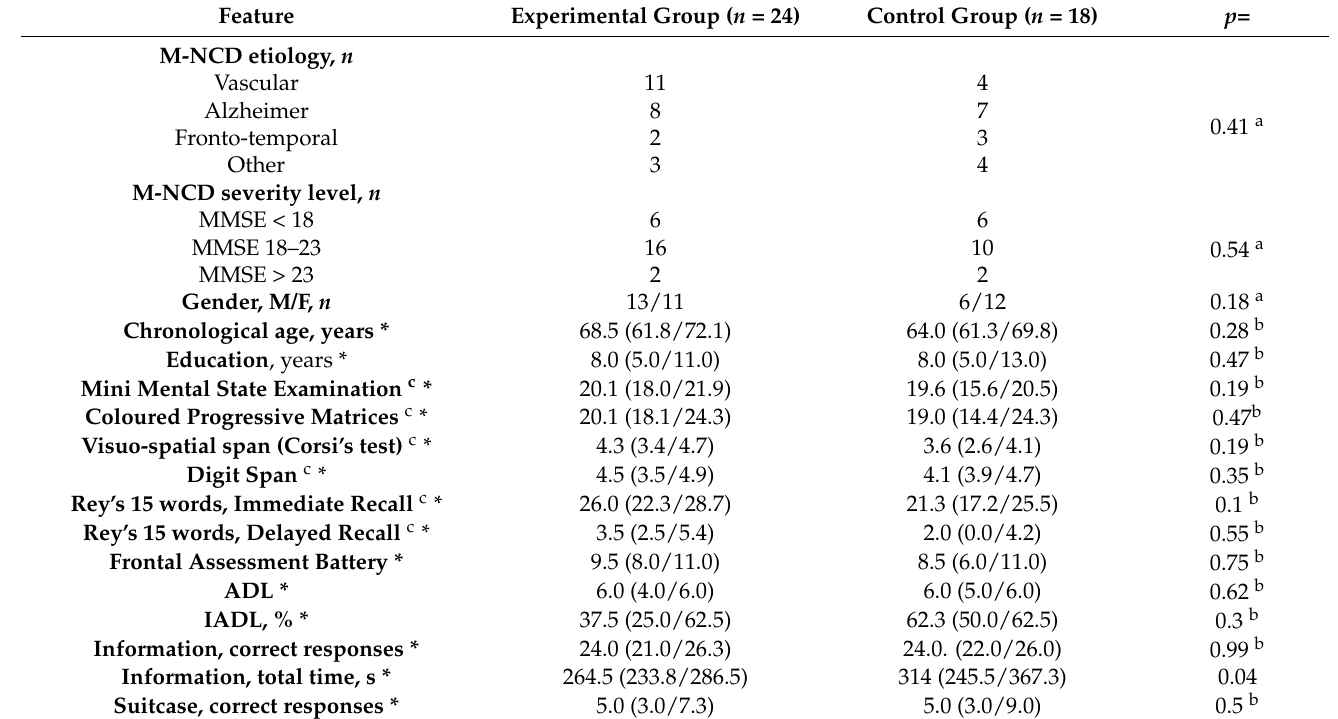
Table 1. Comparison between the clinical and demographic features of experimental and control groups at T1.